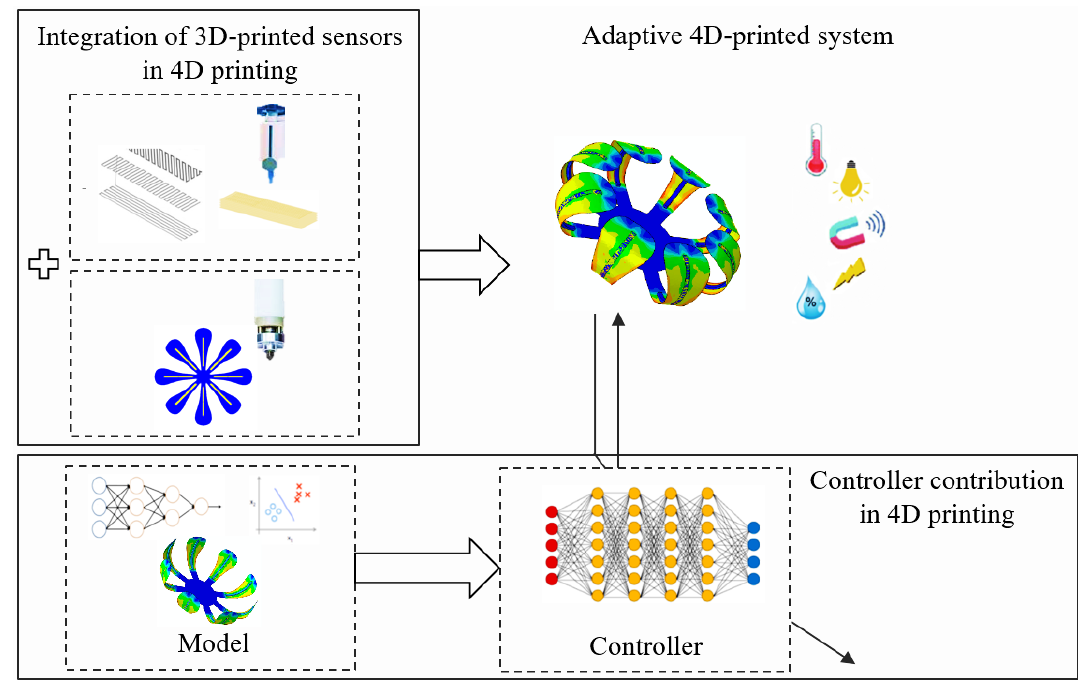
Figure 3. Adaptive 4D-printed systems composition.